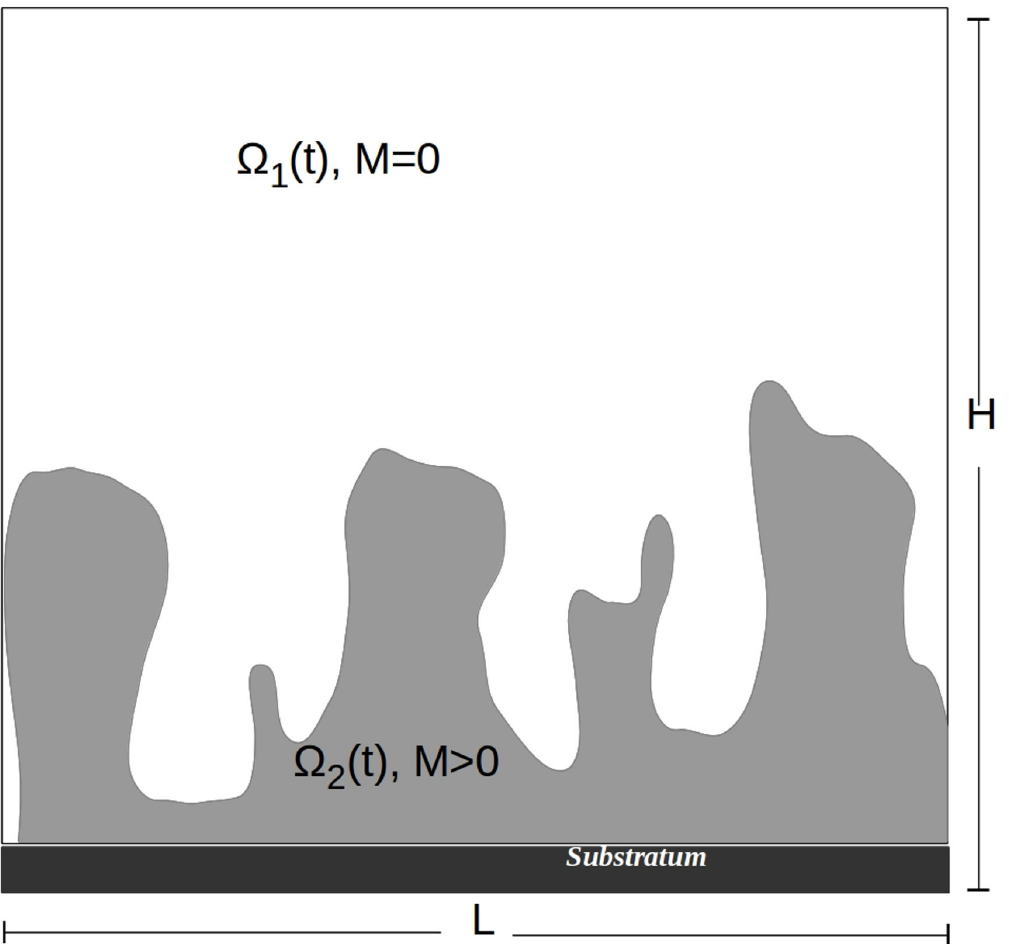
Fig 1. Schematic of the biofilm system. The aqueous phase is the region without biomass present, Ω 1 ( t ) = {( x , y ) 2 Ω : M ( t ; x , y ) = 0}, the biofilm phase is the region with biomass present Ω 2 ( t ) = {( x , y ) 2 Ω : M ( t ; x , y ) > 0}. These regions change over time as the biofilm grows. Biofilm colonies form attached to the substratum, which is a part of the boundary of the